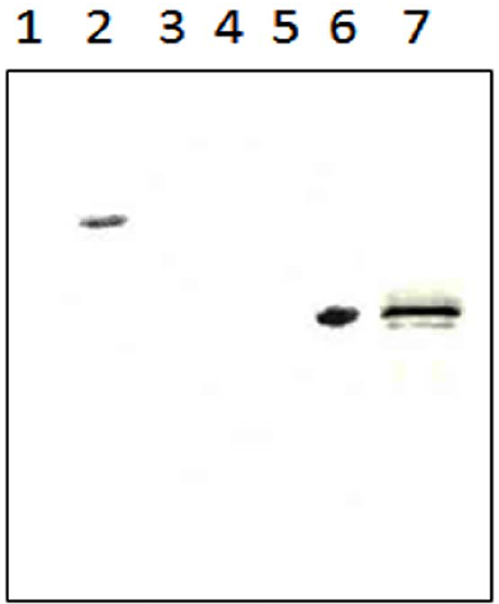
Figure 1. Western blot analysis of Rv1430 full-length protein and PE-PPE domain by anti-His antibody. Lane 1, Uninduced E. coli BL21 (DE3) CodonPlus-RIL transformed with Rv1430 construct; Lane 2, Induced sample- Rv1430 (59.3 kDa); Lane 3, Protein Marker; Lane 4, lysate of E. coli Rosetta gami transformed with an empty vector; Lane 5, Uninduced Rv1430 PE-PPE domain sample; Lane 6, Induced sample- Rv1430 PE-PPE domain (25.8 kDa). Lane 7, Induced sample-Ser199Ala mutated Rv1430 PE-PPE domain (25.8